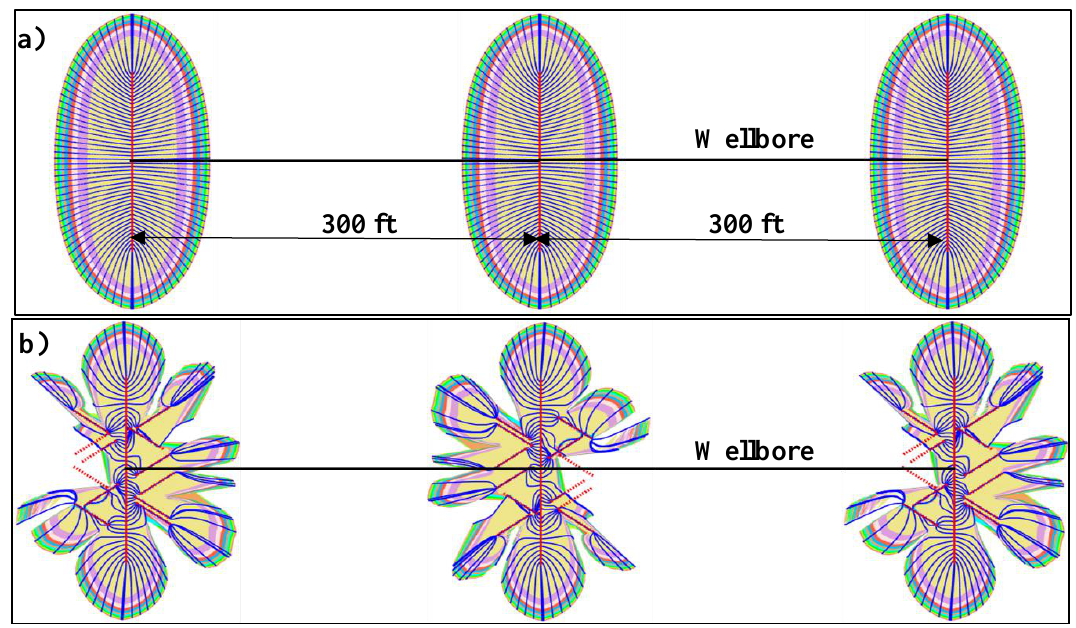
Figure 13. ( a ) Plan view of DRV for modeled well using current stage spacing of 300 ft assuming homogenous reservoir ( b ) Plan view of DRV for multiple stages using current 300 ft spacing with the impact of natural fracture modeled using HFTS data. Hydraulic fracture in red line; natural fractures in dashed red line; streamlines in blue. Rainbow colored fill shows drained areas after 3-year time periods.